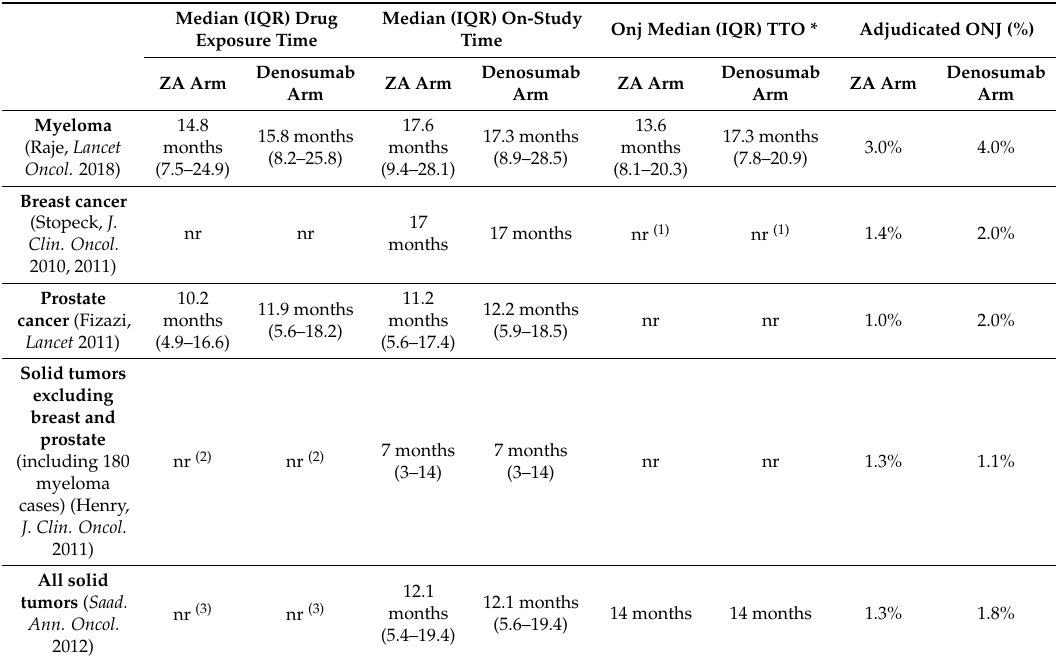
Median (IQR) Drug Median (IQR) On-Study Onj Median (IQR) TTO * Adjudicated ONJ Exposure Time Time